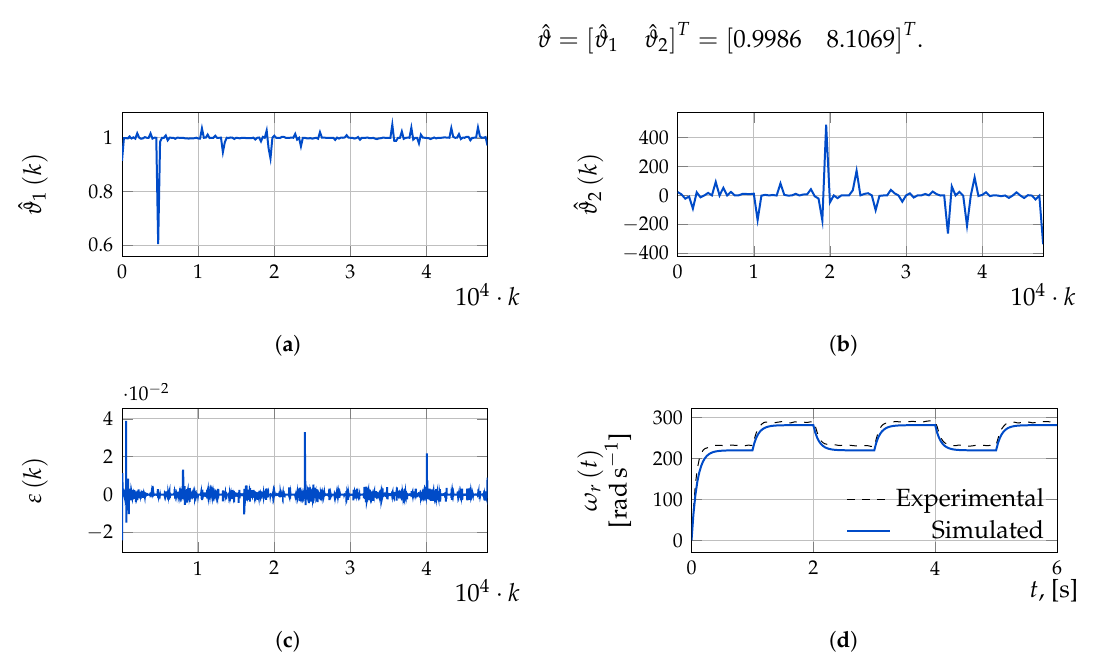
Figure 6. Recursive least-squares results. ( a , b ) showing the parameter trajectories of ˆ ϑ 1 and ˆ ϑ 2 , respectively, ( c ) shows the quadratic error of the algorithm, ( d ) shows the comparison between the measured speed and the speed obtained with the first-order